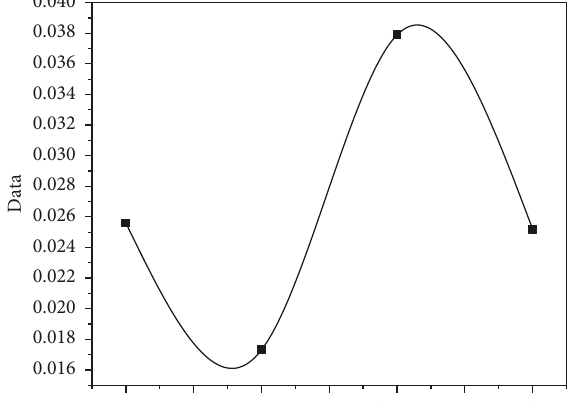
Figure 2: PSO model simulation results.